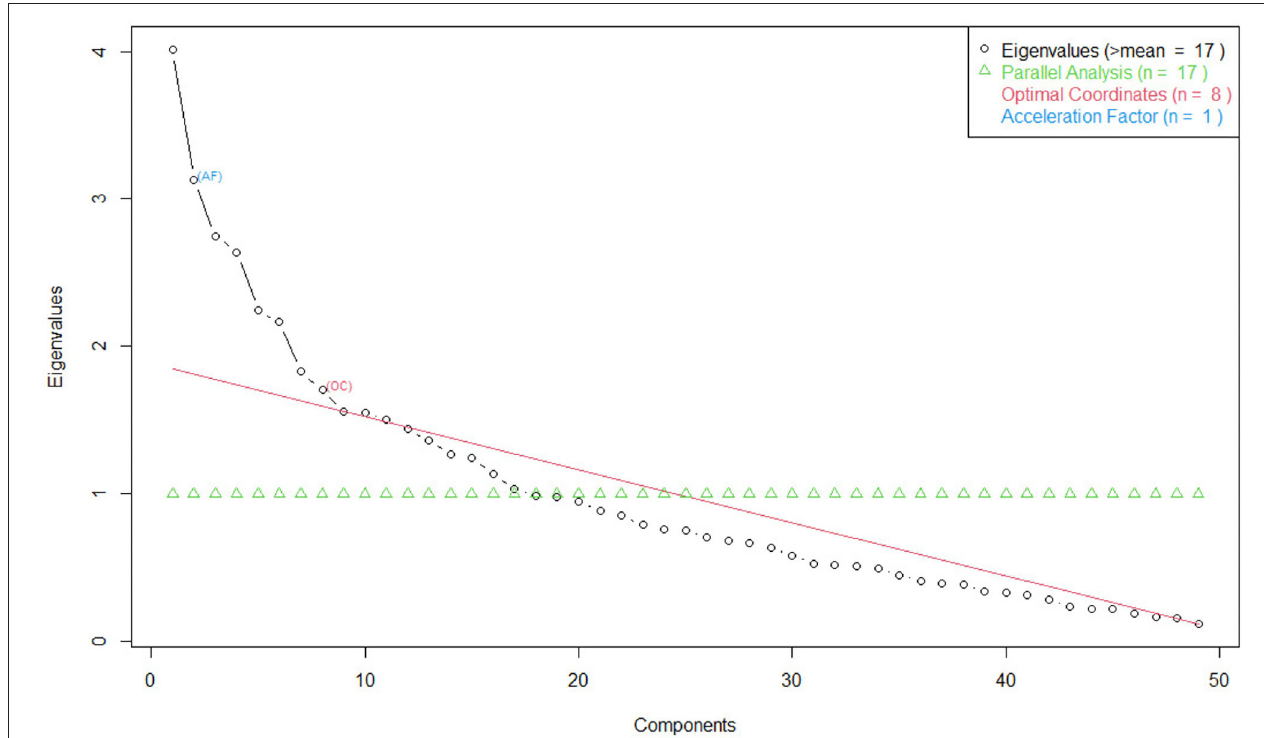
FIGURE 4 | Scree plot of correlation matrix eigenvalues. Potential solutions are shown for parallel analysis (the point where the eigenvalues dip below 1), optimal coordinates (the first eigenvalue that lies above the line connecting the next eigenvalue and the last eigenvalue), and acceleration factor (the point where the curve’s slope changes most